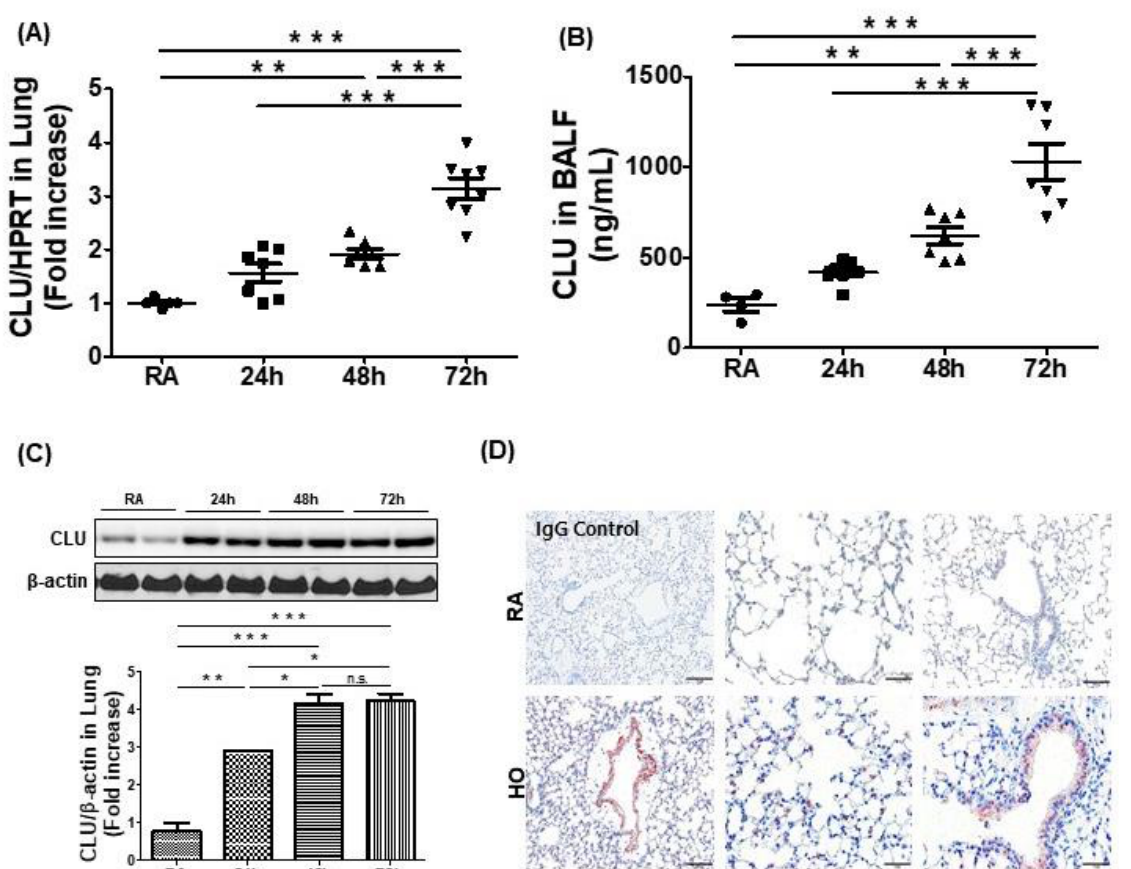
Figure 1. Hyperoxia induces clusterin (CLU) production in mouse lung. Wild-type (WT) mice were exposed to room air (RA) or >95% O 2 (HO) for up to 72 h. ( A ) Time-course of CLU expression as measured by real-time PCR in the lung tissues of mice exposed to either HO or RA control. ( B ) The level of CLU in bronchoalveolar lavage fluid was assessed using ELISA. ( C ) Pulmonary CLU protein expression was assessed via Western blotting. ( D ) CLU immunohistochemistry in lung sections exposed to HO or RA control. The images are representative of a minimum of 4 mice per group. Each symbol in A and B represents the value for every mouse. Scale bars in ( D ); 100 µ m; n.s. = not significant; * p < 0.05, ** p < 0.01, *** p < 0.001.